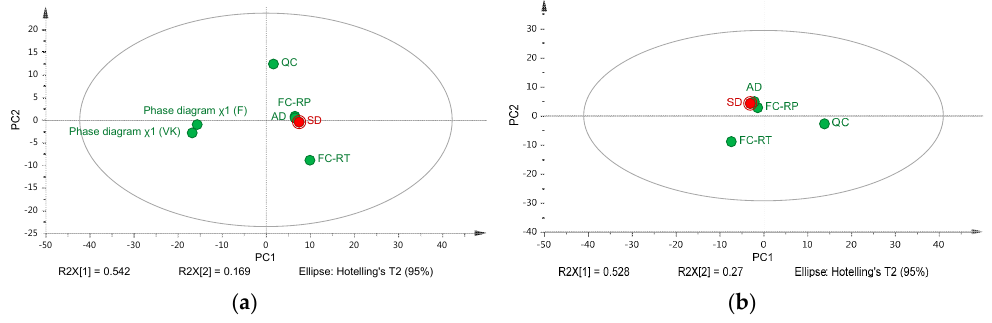
Figure 9. ( a ) Principal component analysis (PCA) score plots analysis of drug–polymer miscibility predicted by thermodynamic models and obtained for ASDs produced by film casting performed: at RT (FC-RT) and under reduced pressure (FC-RP); (QC) quench cooling, (AD) atomization screening device, and (SD) spray dryer for IBU, NAP, CAR, and ITR mixed with the set of polymers tested; ( b ) The PCA was repeated excluding the thermodynamic models from the comparison. The miscibility prediction given by the thermodynamic models was found to be not in good